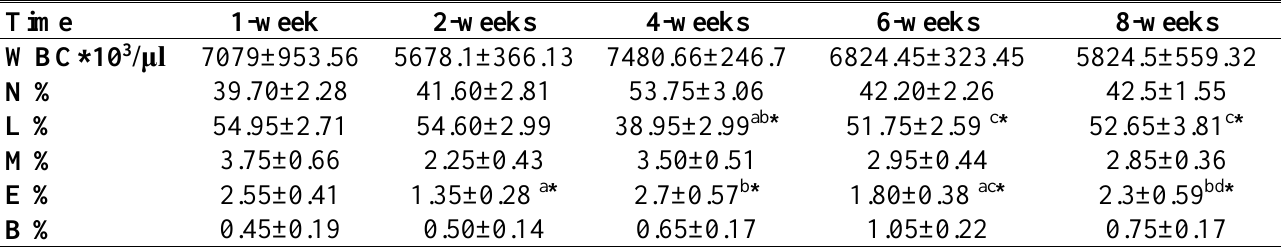
Table 4. Total leukocyte count and differential leukocytes in experimentally induced zinc deficiency in